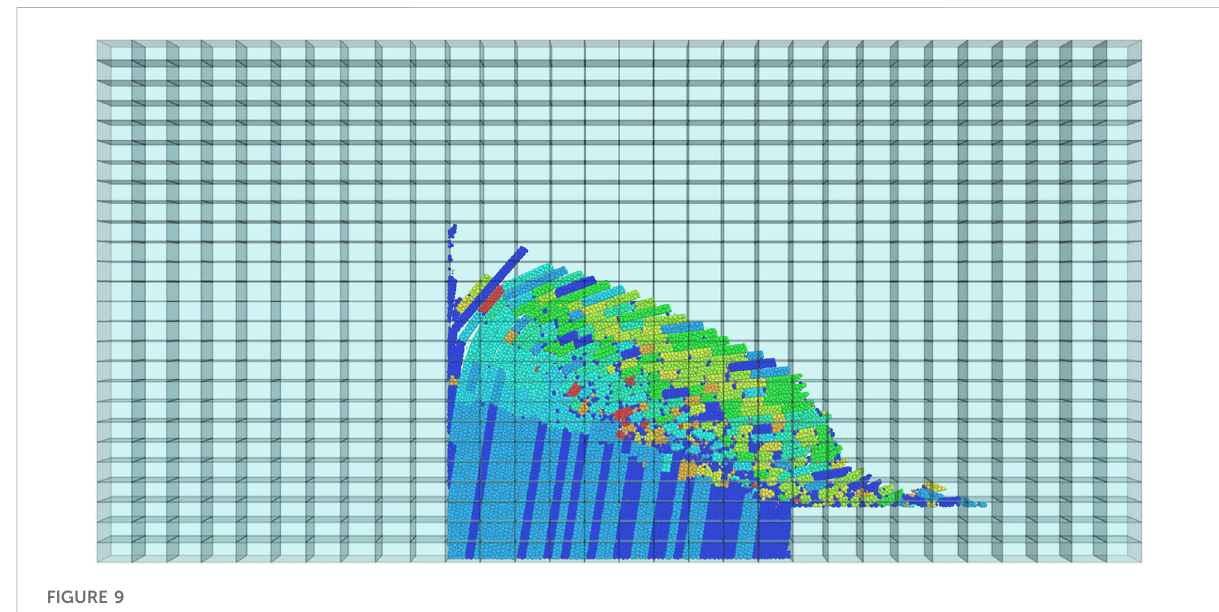
FIGURE 9 Post failure results in static water.